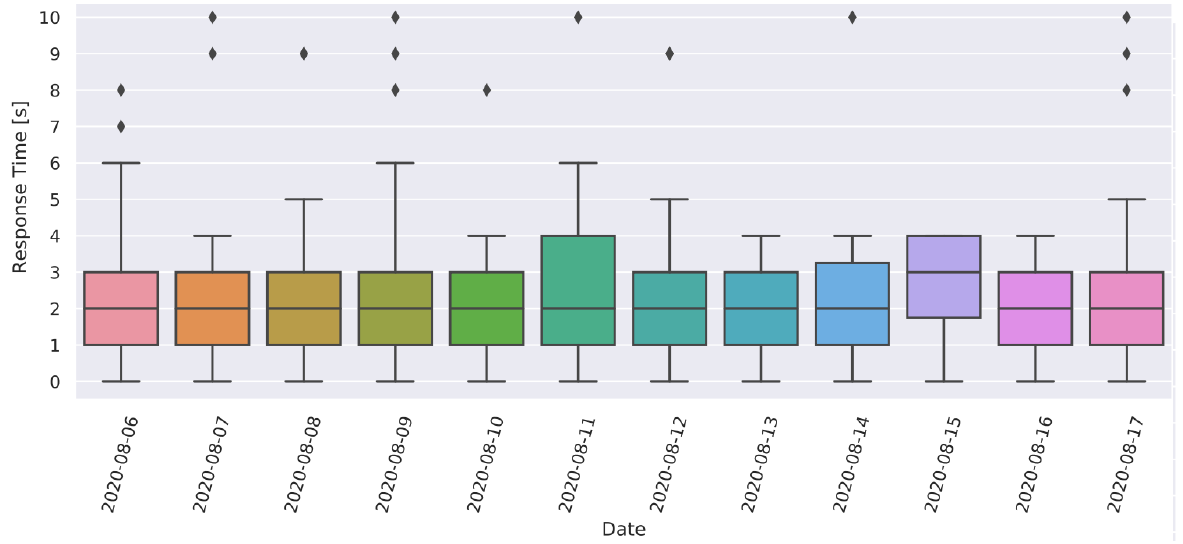
Figure 23. Messages response time over testing period.